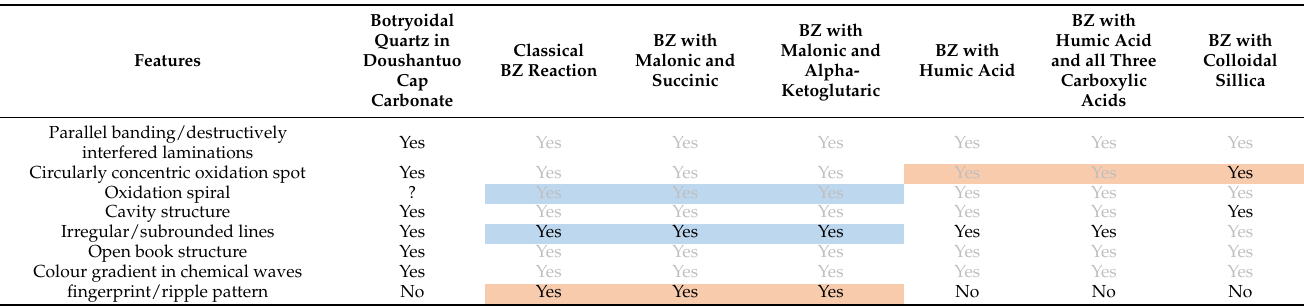
Table 1. Characteristics of BZ patterns classified by the most common types of simple features.